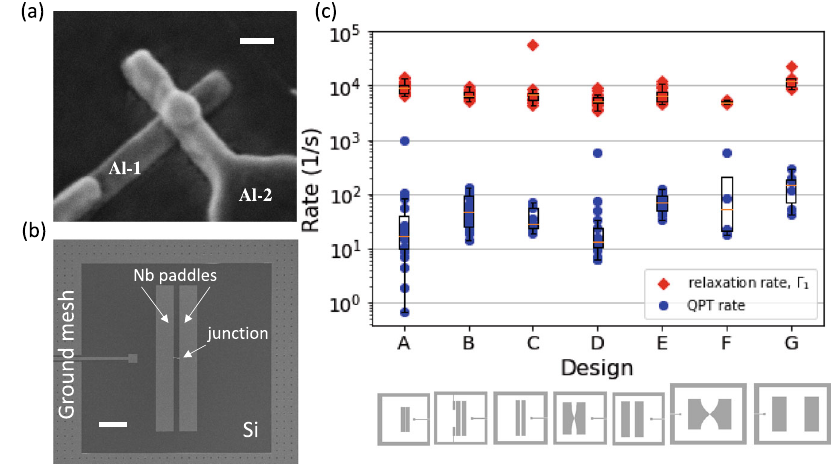
Fig. 1 Non-equilibrium quasiparticles in various designs of Nb qubits. a Scanning electron microscopy (SEM) image of a JJ in one of our transmon qubits showing the superconducting Al leads sandwiching a thin layer of AlO x . The scale bar corresponds to 100 nm. b SEM image of a standard transmon (design-C) incorporating a single Al/AlO x /Al JJ and Nb capacitor paddles. The scale bar corresponds to 100 μ m. c QPT and relaxation rates vs. qubit design for a set of qubits with Nb paddles, the medians are shown in orange. The cartoons depict the various qubit designs used in this work from A to G with increasing paddle area.